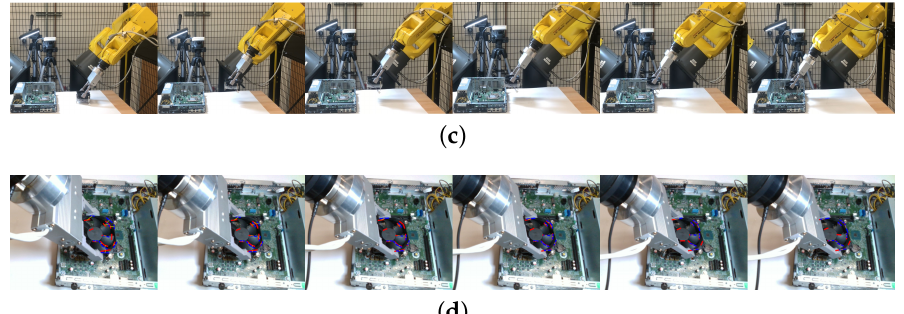
Figure 16. ( a ) CPU fan installation by human demonstration; From human demonstration, 3D imitated trajectories and 2D line features used for visual servoing are generated. ( b ) Line feature error ( ρ , θ ) between target and current images converge to zero. ( c ) The robot executes a imitated trajectory generated from human demonstration. ( d ) The robot executes a fine-tuned trajectory through the use of visual servoing.